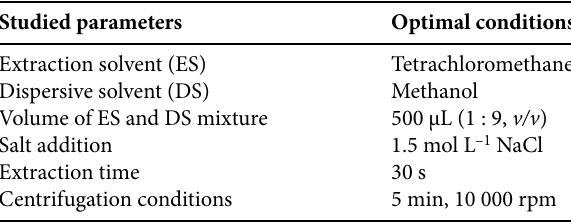
Table 1. Conditions for optimized DLLME method